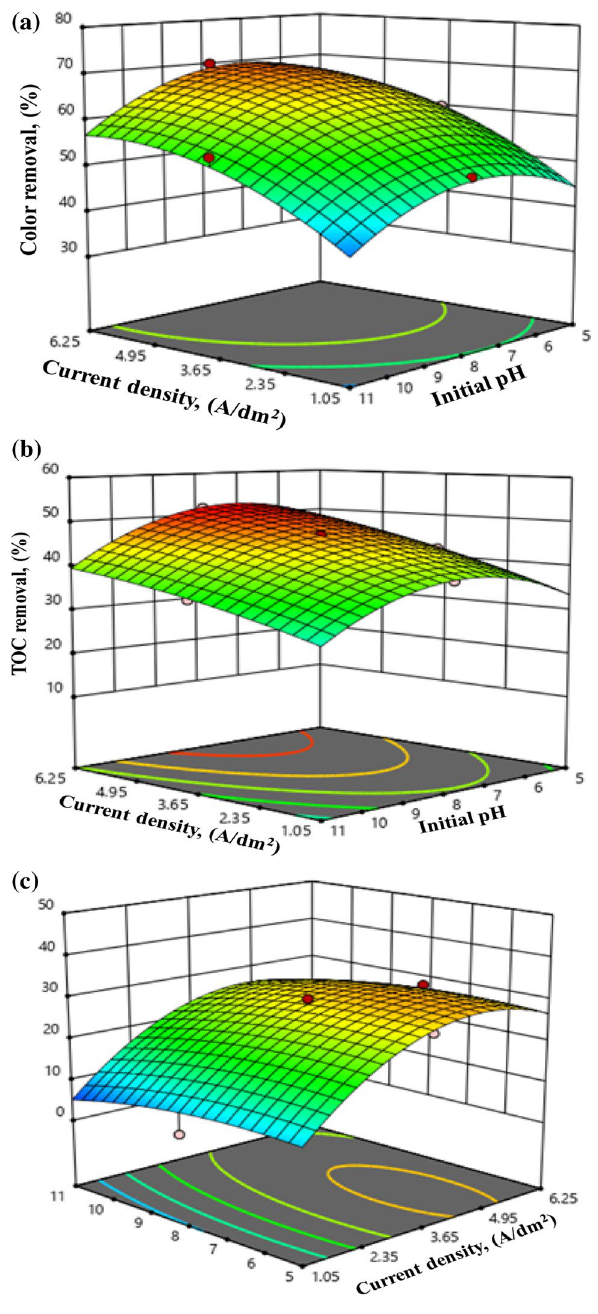
Fig. 4 Combined effect of initial pH ( X a % color removal, b % TOC removal and c power consumption